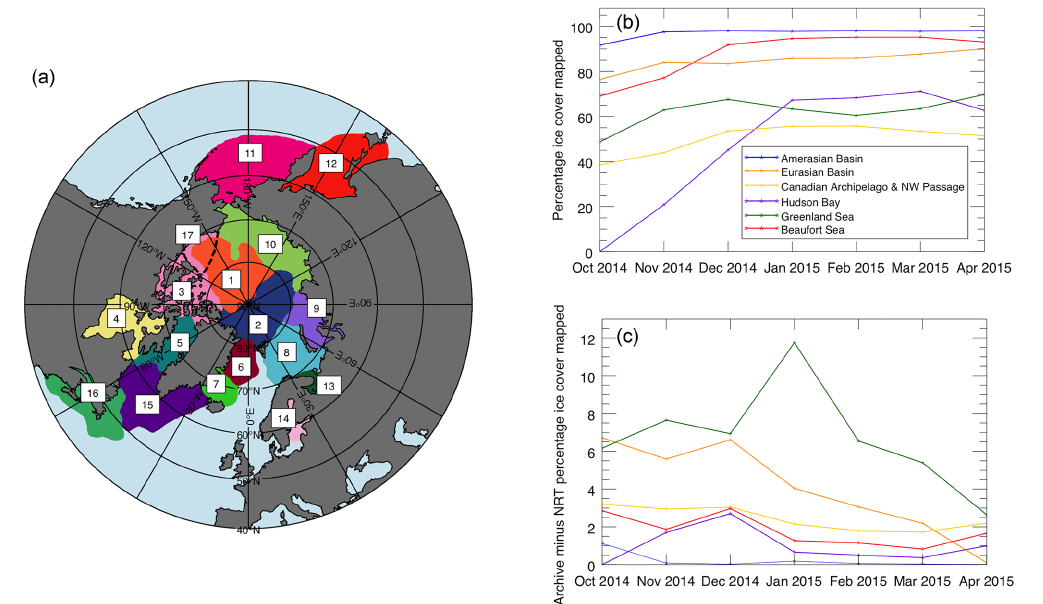
Figure 5. Regional and temporal sampling of the Centre for Polar Observation and Modelling (CPOM) near-real-time (NRT) and archive Arc- tic sea-ice-thickness products. (a) Arctic Ocean regions. The regions are the Amerasian Basin (1), Eurasian Basin (2), Canadian Archipelago and Northwest Passage (3), Hudson Bay and Foxe Basin (4), Baffin Bay (5), Greenland Sea (6), Iceland Sea (7), Barents Sea (8), Kara Sea (9), Siberian shelf seas (10), Bering Sea (11), Sea of Okhotsk (12), White Sea (13), Baltic Sea and surrounding gulfs (14), Labrador Sea (15), the Gulf of St Lawrence and Nova Scotia Peninsula (16) and the Beaufort Sea (17). Regions 1–10 encompass all autumn sea ice, and regions 1–16 encompass all spring sea ice. Region 17 is a subregion of regions 1 and 3. (b) Plot showing the percentage of sea ice cover mapped by the NRT product in each month for six key oceanographic basins. (c) Plot showing the difference (archive – NRT) in percentage ice cover